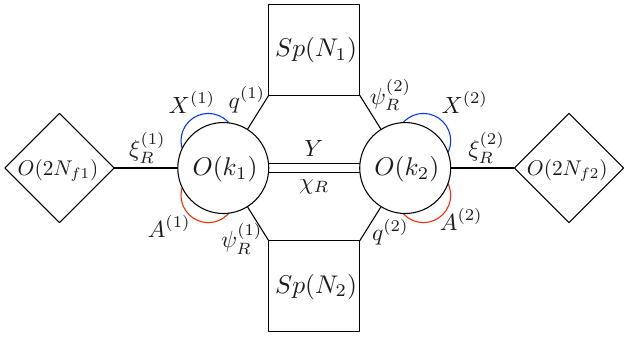
(cid:2) Sp( N 1 ) 2 ) with a bi-fundamental hypermultiplet